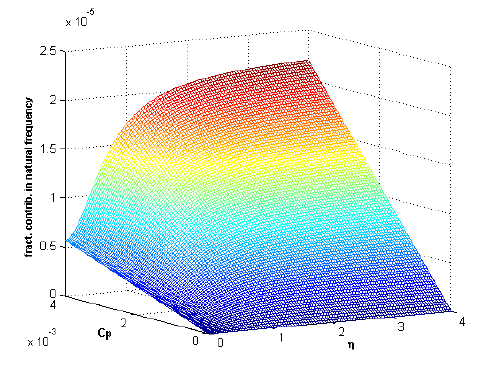
Figure 15. Fractional contribution frequency versus fractional damping coefficient Cp and nonlocality η ( α = 0.2).